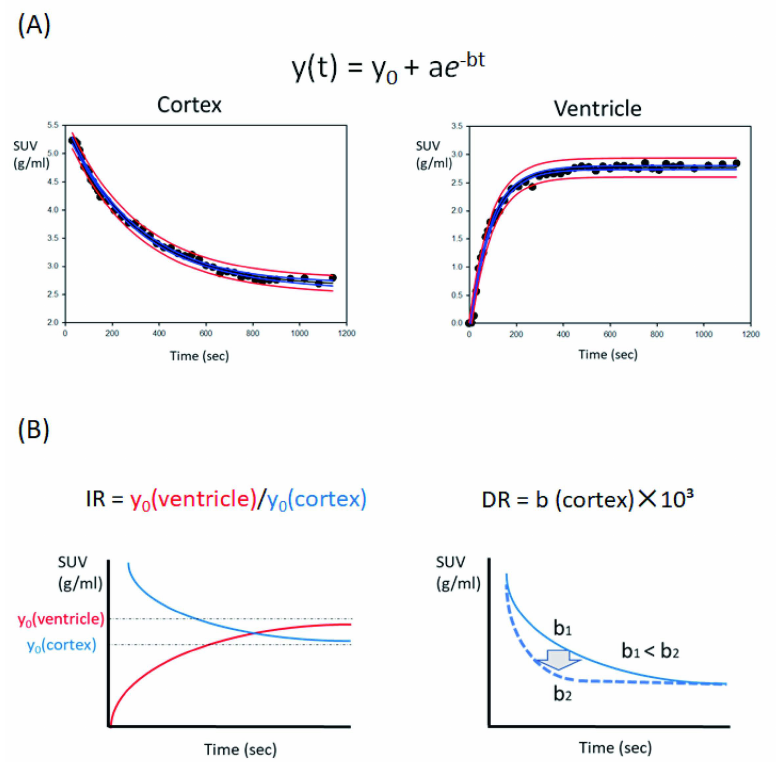
Figure 3. Data analysis in [ 15 O]H 2 O PET. ( A ) Time activity concentration presented as the SUV (g/mL) in the cortex and ventricle. The data were fitted to an exponential curve, y(t) = y 0 + a e − bt . The blue and red lines represent the 95% confidence and prediction band. The parameters y 0 and b are the implied tissue baseline SUV and flow pace, respectively. ( B ) Two indices were used for assessing interstitial flow: influx ratio (IR) and drain rate (DR). The two indices were defined as follows: IR = y y 0(cortex) and DR = b (cortex) × 10 3 , and the blue and red lines in the schematic 0(ventricle) / figure represent the cortex- and ventricle-fitted curves. IR is the index for the flow of water into the CSF space from the cortex, with a higher value indicating a larger water flow. DR is the index for the rate of water drainage into the CSF space from the cortex, with a larger value indicating a higher flow speed. When b 2 (dotted line) is larger than b 1 (solid line), as shown in the figure, the flow speed of b 2 is higher than that of b 1